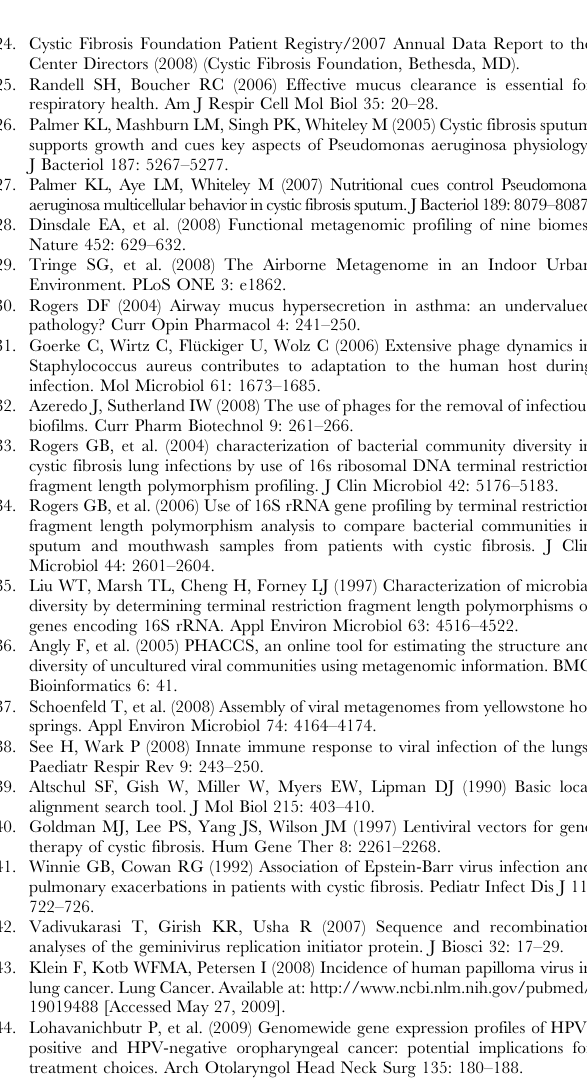
Figure S3 Supplementary Figure 3. Percentage of metagenomic sequences with known and unknown metabolic functions as determined by BLASTx to the SEED database. A sequence was considered as known if it had a significant (e-value , 10 2 5) hit to a gene in a metabolic pathway. Figure S4 Supplementary Figure 4. Coverage of the Strepto- coccus pneumonia phage Cp-1 genome in metagenome Non-CF2 by raw metagenomic sequences as determined by tBLASTx (A) and by assembled contigs as determined by BLASTn (B). The graphic of the 19,343 kb phage Cp-1 genome is from NCBI (http://www.ncbi.nlm.nih.gov). Found at: doi:10.1371/journal.pone.0007370.s009 (0.11 MB Figure S5 Coverage of the Haemophilus influenza prophage Mu genome in the CF6 metagnome by raw metagenomic sequences as determined by TBLASTX (A) and by assembled contigs as determined by BLASTn (B). The graphic of the 43033 kb prophage Mu genome is from NCBI (http://www.ncbi. nlm.nih.gov).